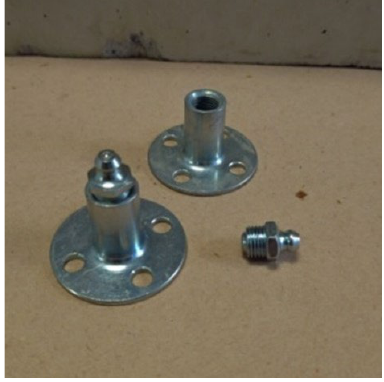
Figure 3. Surface